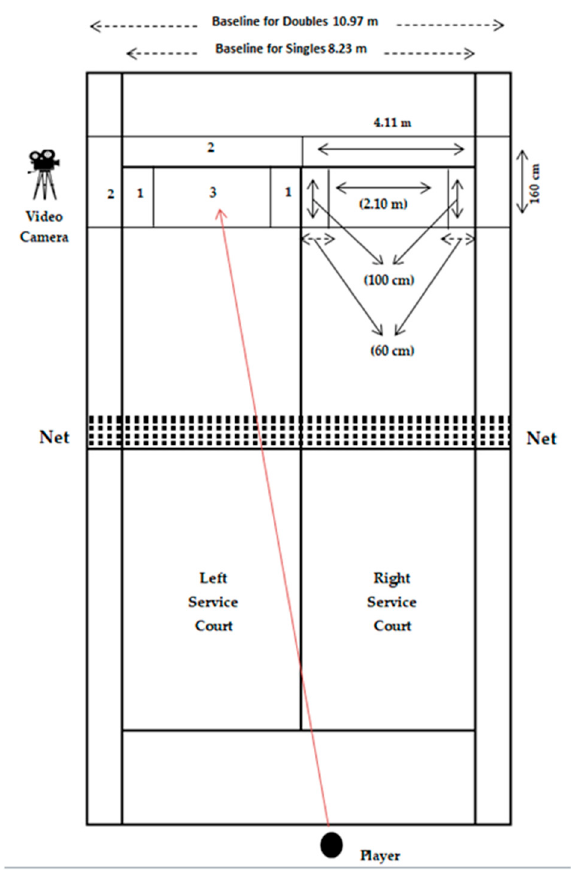
Figure 1. Experimental set up on the tennis court. (Number of the zones are indicated as 1 = target zone, 2 = non-target ironic error zone and 3 = non-target non-error zone.).